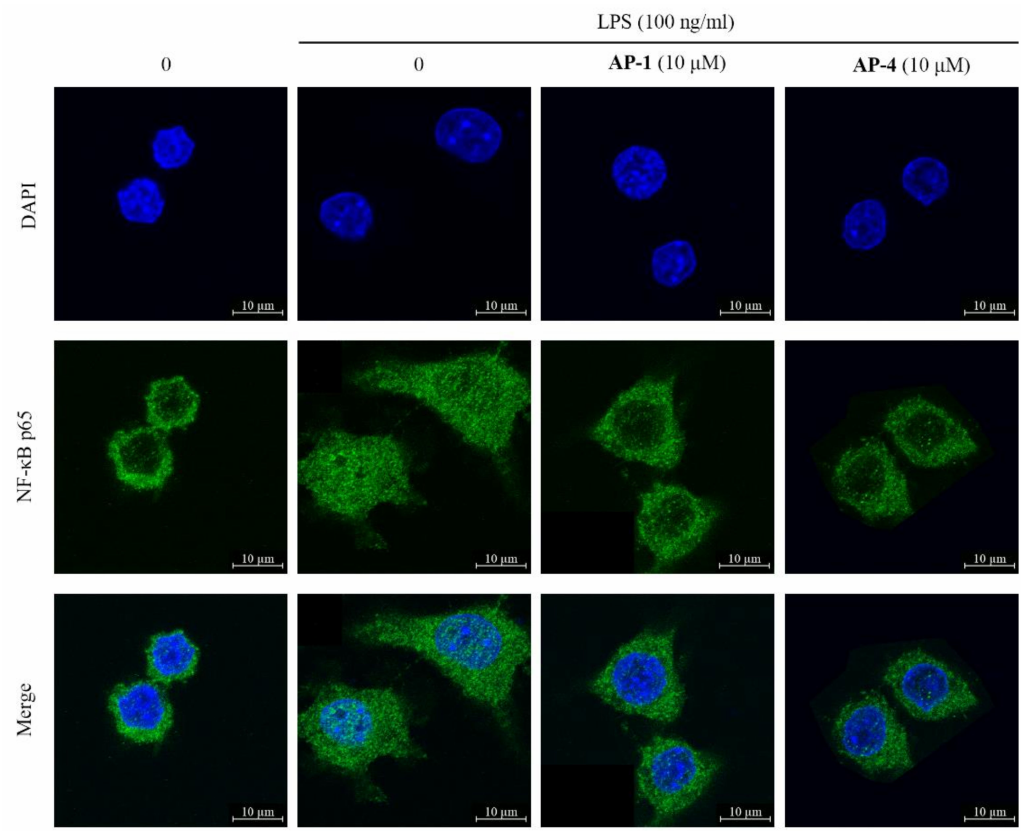
Figure 10. AP-1 and AP-4 prevented LPS-induced nuclear translocation of NF- κ B p65 in RAW 264.7 macrophages. RAW 264.7 macrophage cells were pretreated with AP-1 or AP-4 (10 µ M) for 2 h and incubated with or without LPS (100 ng / mL) for another 16 h. Then, cells were observed using a confocal microscope (400 × , LSM880, Carl Zeiss,